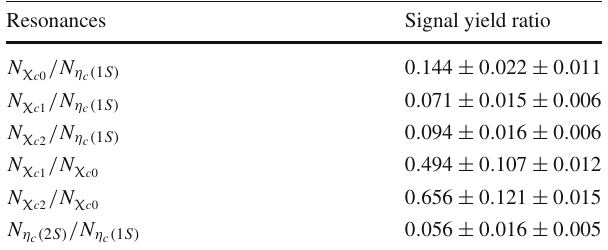
Table 2 The ratio of charmonium signal yields with respect to the η ( 1 S ) yield and between pairs of χ c statistical and the second